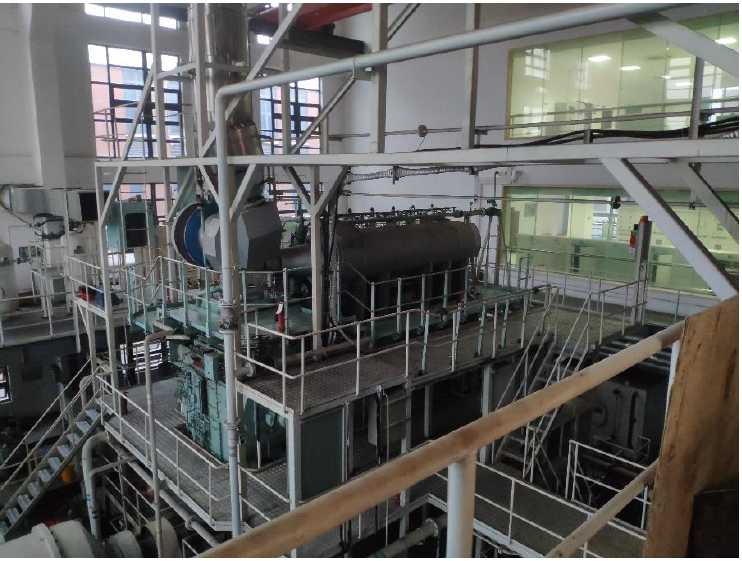
Figure 3. Ship diesel engine selected for the experiment.